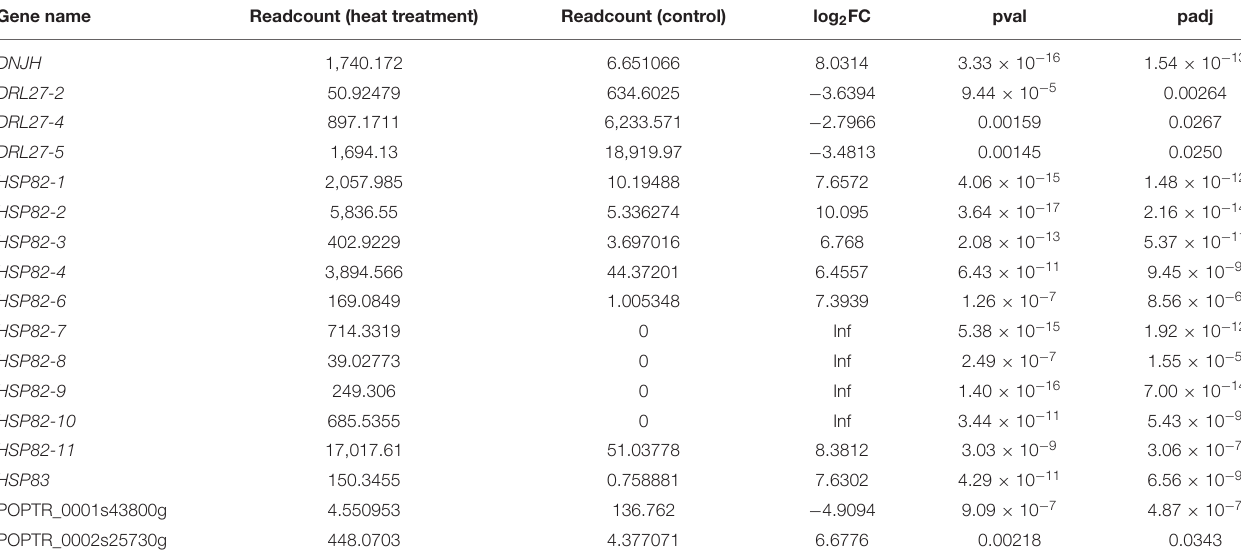
TABLE 3 | The DEGs in GO term related to heat